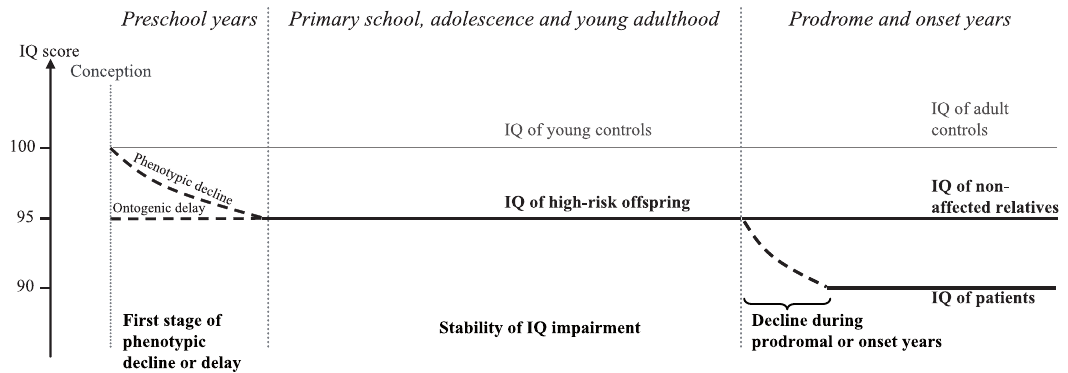
Figure 3. Illustration of a putative three-stage progression toward disease for Global IQ impairment. The first stage would extend from conception/pregnancy until 3 to 6 years old and would be characterized by a phenotypic decline of 5–8 points and/or ontogenetic delay in children at risk. During the second stage, from primary school years until young adulthood, youths at risk would present a stable IQ deficit. The third stage, beginning around the prodromal years, illustrates the drop of 5–8 points of IQ suffered by patients. Dotted lines represent sequences of change or decline periods during the life of an individual, plain lines represent stability period in IQ. This study encompassed only the period of Primary school, adolescence and young adulthood